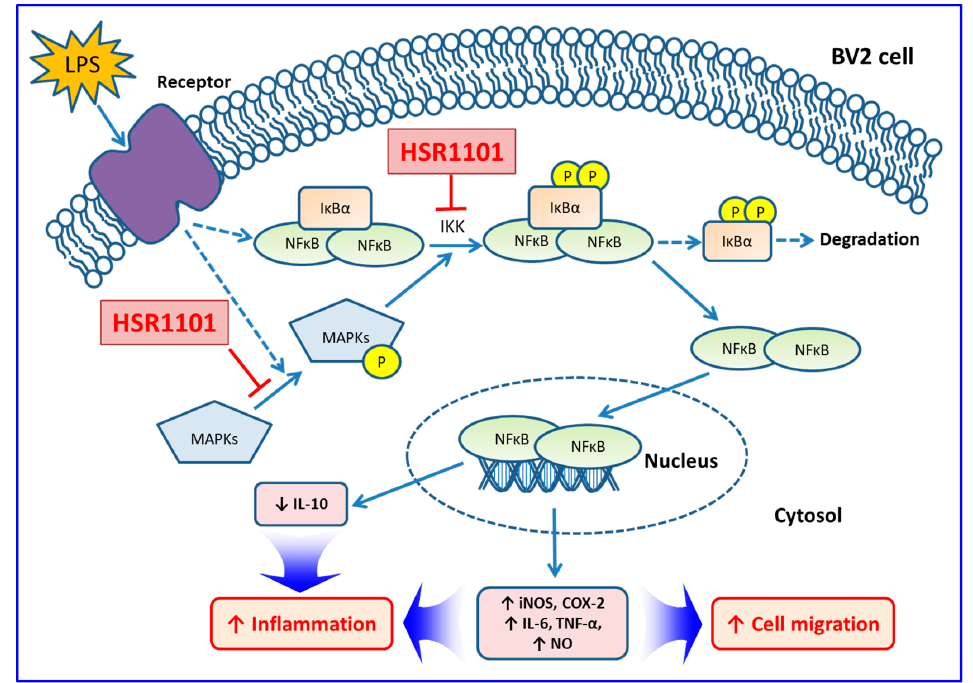
Figure 9. A schematic diagram showing the signaling pathways involved in anti-inflammatory and anti-migratory actions by HSR1101 in BV2 microglial cells. Solid arrows indicate the pathway(s) examined, while dotted arrows indicate the pathway(s) not examined in this study. LPS, lipopolysaccharide; NF- κ B, nuclear factor-kappa B; I κ B α , inhibitor of kappa B alpha; IKK, inhibitor of kappa B kinase; MAPKs, mitogen-activated protein kinases; iNOS, inducible nitric oxide synthase; COX-2, cyclooxygenase-2; IL-6, interleukin-6; TNF- α , tumor necrosis factor-alpha; NO, nitric oxide; IL-10, interleukin-10, P, phosphorylation.